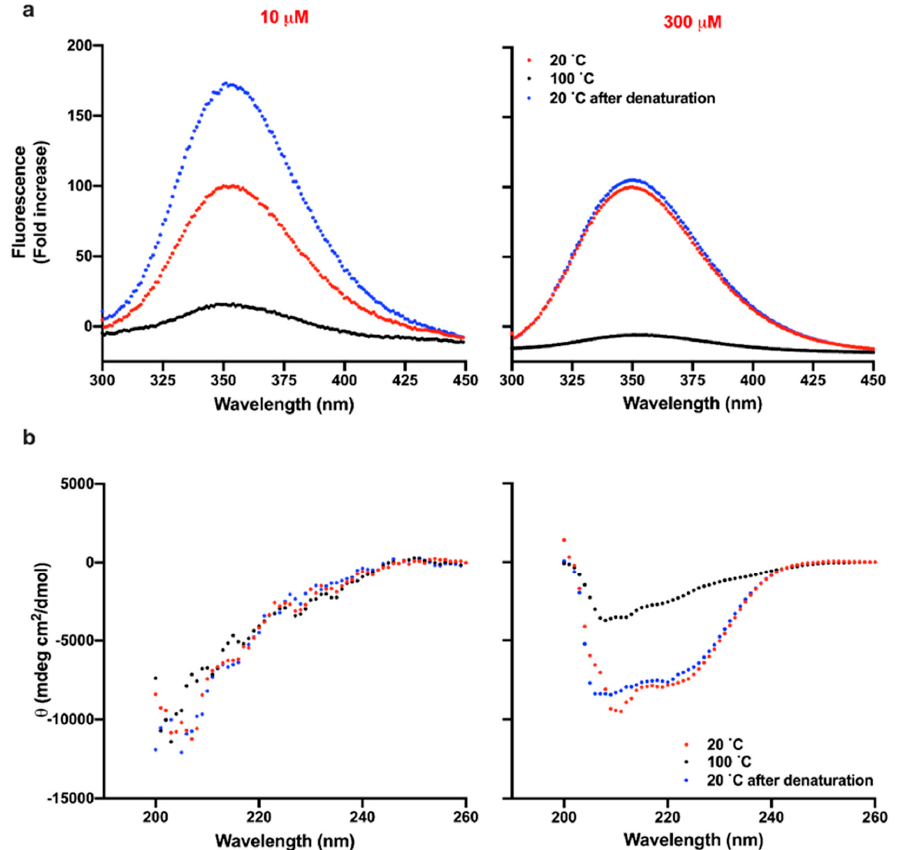
Figure 4. Reversibility of thermal denaturation of TCP-25 at pH 7.4. 10 and 300 µ M TCP-25 in 10